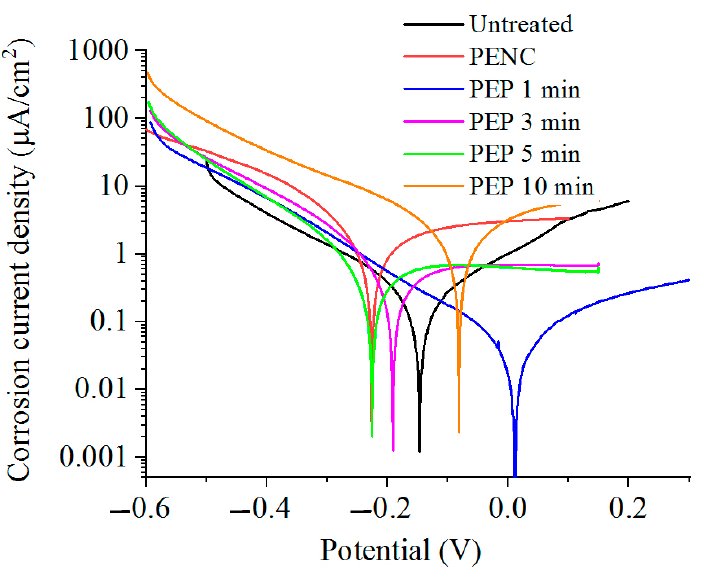
Figure 8. Potentiodynamic polarization curves of the CP-Ti samples before and after anodic PENC at 900 °C and subsequent PEP in a solution of ammonium chloride (1%) at 300 V for different time.